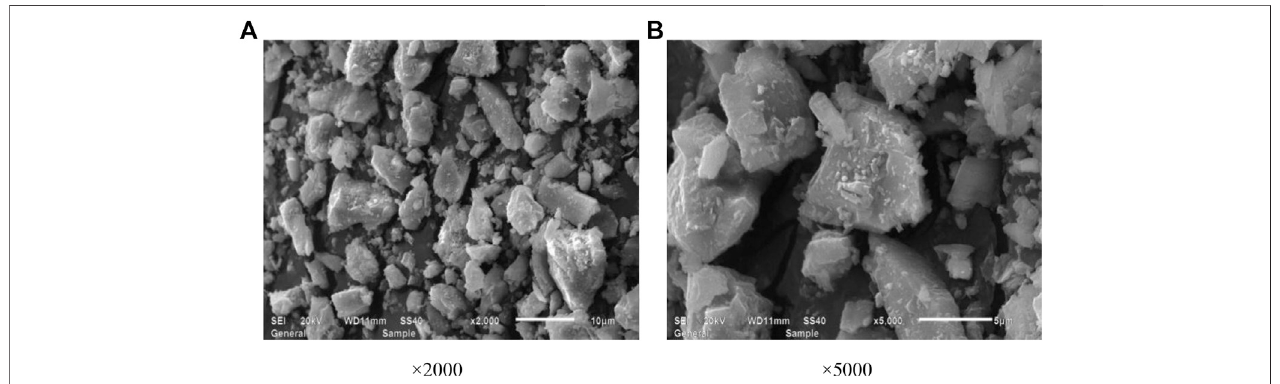
FIGURE 2 | SEM Images of Tuff Powder.